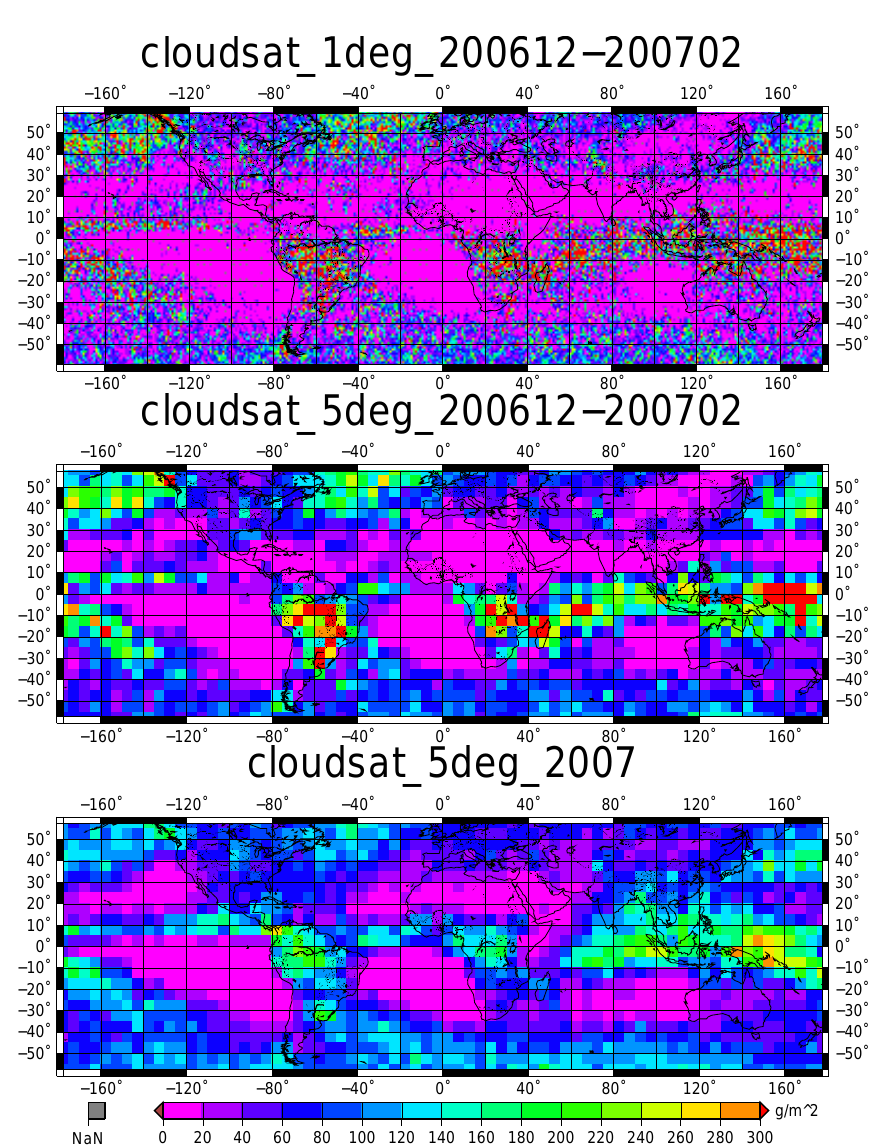
Fig. 1. An IWP climatology from CloudSat data. Top panel: seasonal climatology (winter 2006/2007) at 1 ◦ spatial resolution. Middle panel: same seasonal climatology at 5 ◦ resolution. Bottom panel: yearly climatology (2007) at 5 ◦